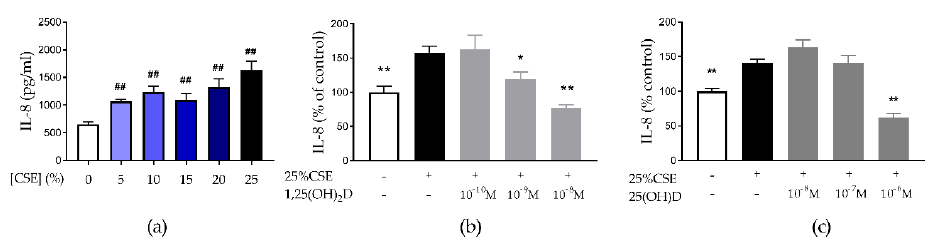
Figure 1. Effect of cigarette smoke extract (CSE) exposure and vitamin D (vitD) treatment on IL-8 secretion by 16HBE cells. ( a ) Increase in IL-8 secretion by 16HBE cells after 24 h CSE-exposure. ( b , c ) IL-8 secretion by 16HBE cells was decreased by 30 min pretreatment of vitD followed by 24 h exposure of CSE with 1,25(OH) 2 D and 25(OH)D respectively. ## p < 0.01 compared to 0%, * p < 0.05 compared to 25% CSE, ** p < 0.01 compared to 25% CSE. Data pertain to the result of two independent experiments with three replicates each. 3.2. Both 1,25(OH) 2 D and 25(OH)D are Able to Induce Cathelicidin Expression in 16HBE Cells It was found that 1,25(OH) 2 D significantly upregulated cathelicidin mRNA expression in 16HBE